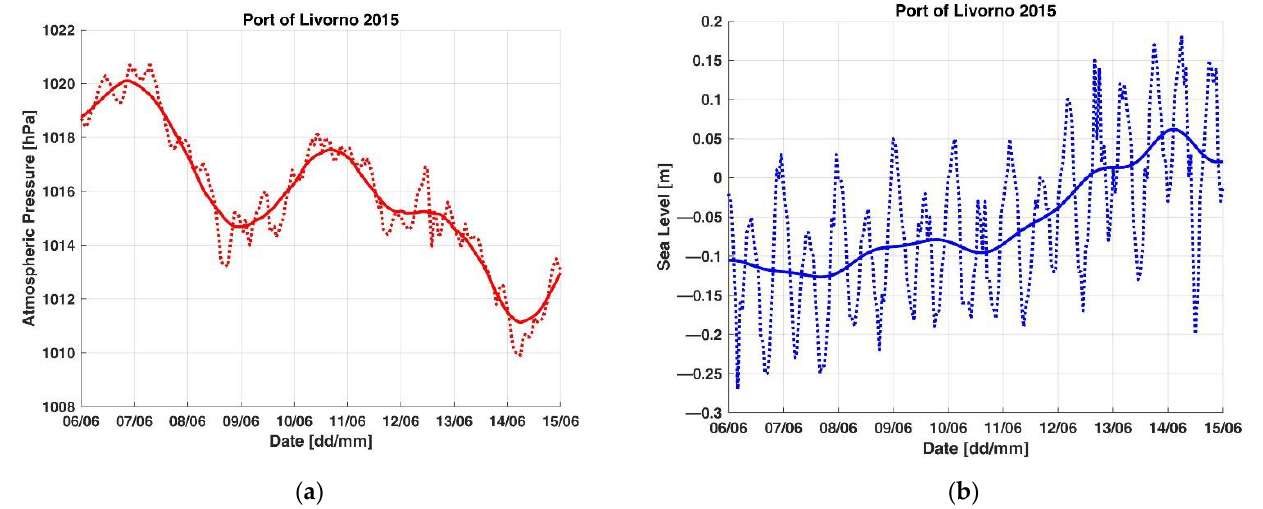
Figure A5. Low-frequency components of meteo-mareographic parameters acquired by ISPRA’s monitoring station in the port of Livorno from 6 to 15 June 2015: ( a ) atmospheric pressure; ( b ) sea level.